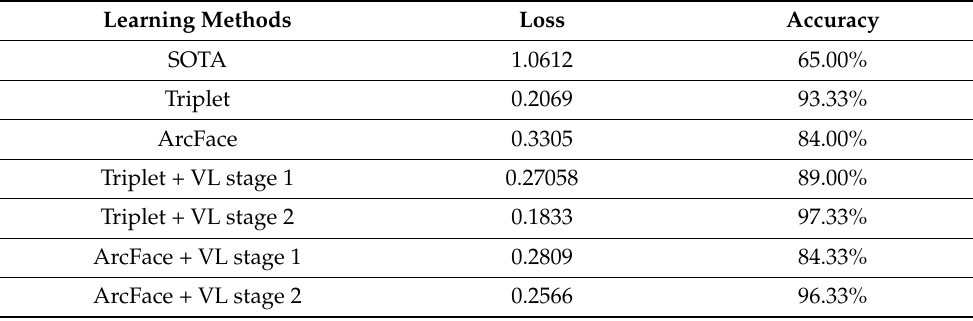
Table 2. Loss and accuracy of learning methods for the architecture described in Section 3.1. Vector length (VL) method indicates vector length